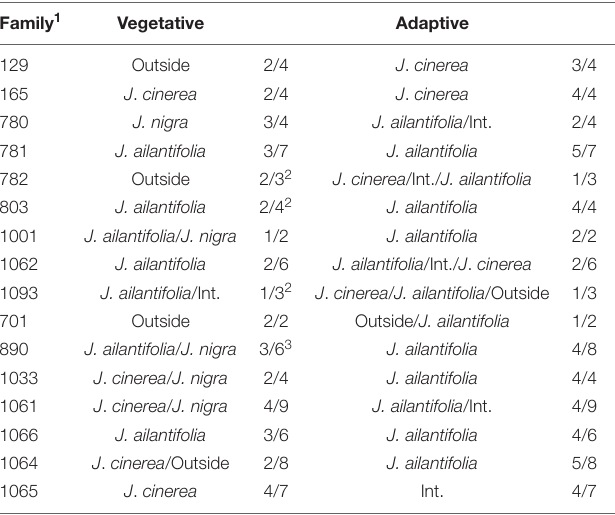
TABLE 5 | Juglans × bixbyi Rehd. family breakdown of parameter space assignments based upon the vegetative and adaptive trait discriminant